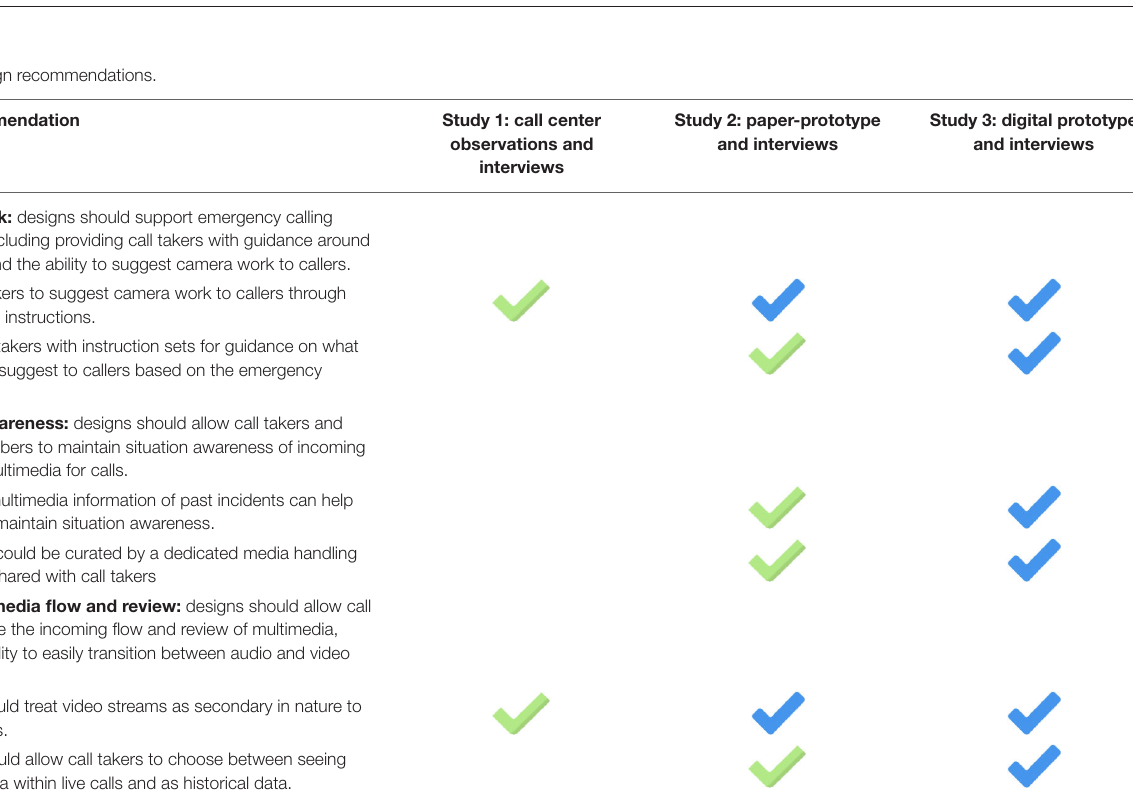
FIGURE 10 | Updated digital map screen.